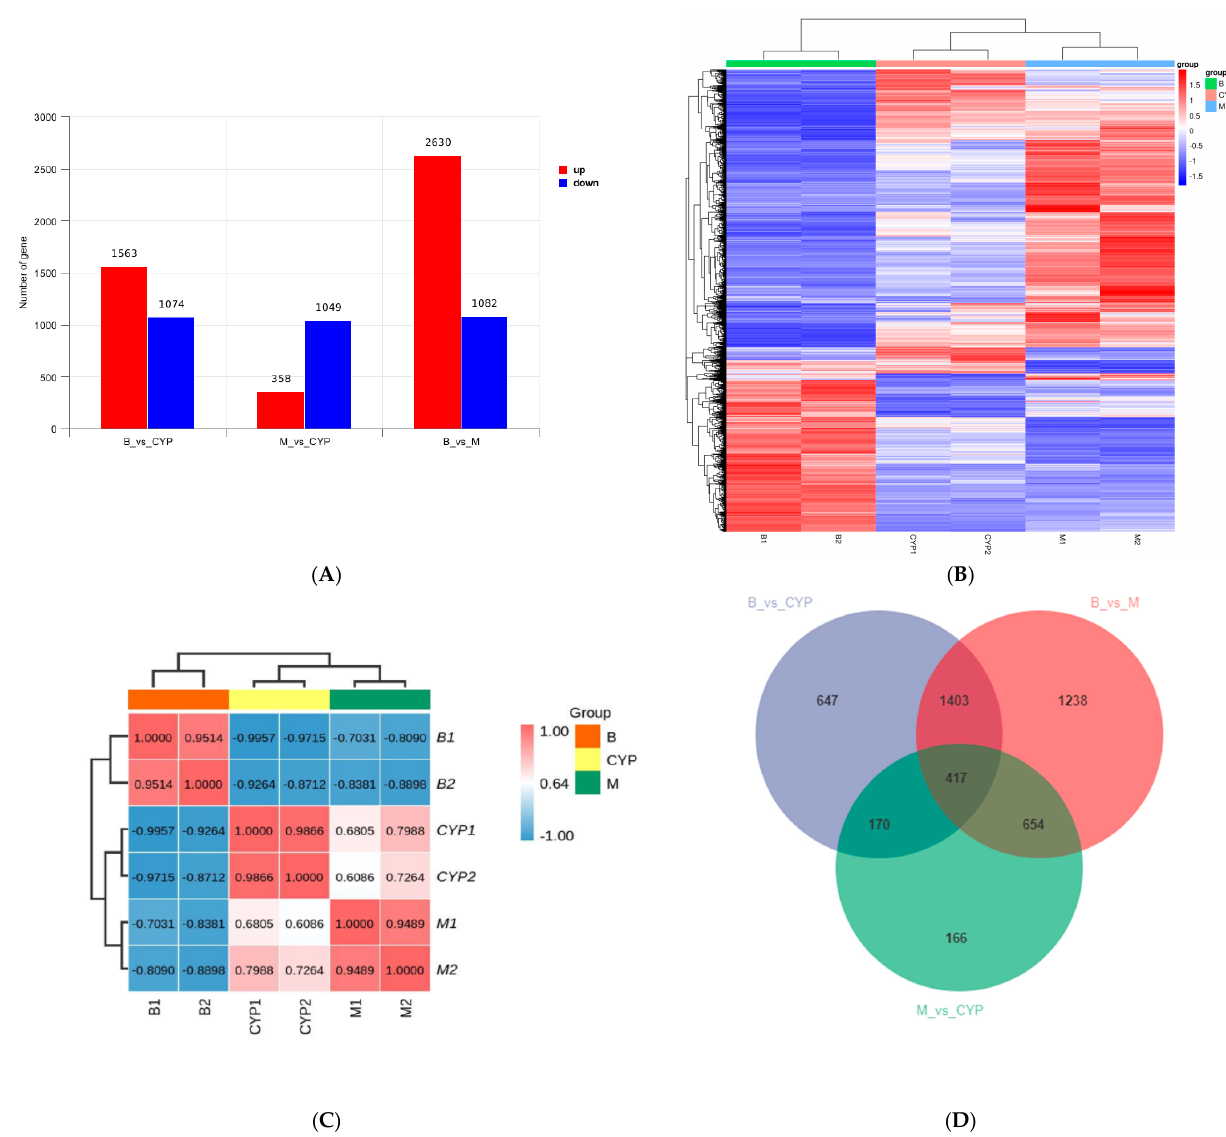
Figure 2. Changes in the mRNA expression profile of IEC-6 cells induced by H 2 O 2 after CYP pre- treatment. ( A ) Statistics of differentially expressed genes between groups. ( B ) DEGs thermogram representation between groups. ( C ) Correlation test between groups. ( D ) Venn diagram between